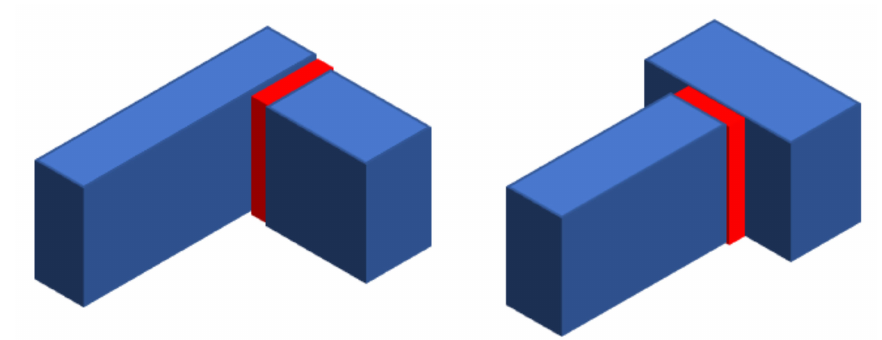
Figure 15. Examples of seismic joints to avoid pounding between the